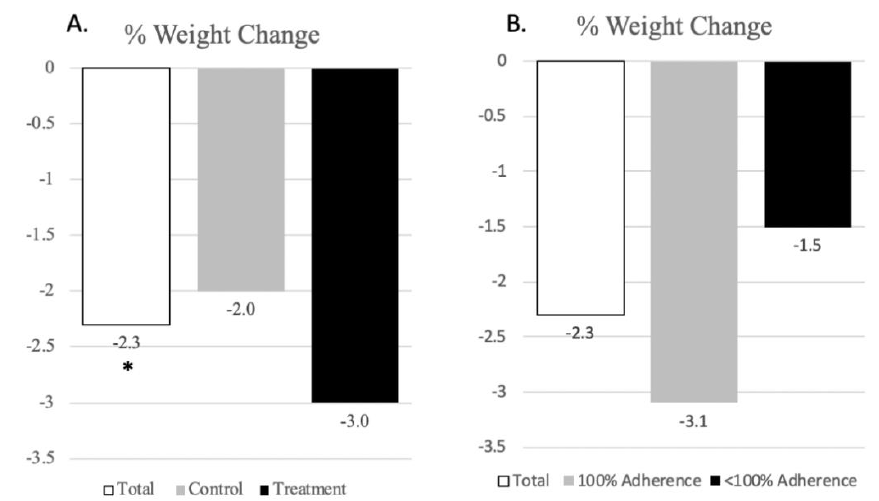
Figure 2. Mean changes in weight (% change) in total participants ( n = 10), the control ( n = 7) and treatment ( n = 3) groups ( A ) and by recommendation adherence ( B ). * indicates statistical significance using Wilcoxon signed rank test ( p < 0.05).